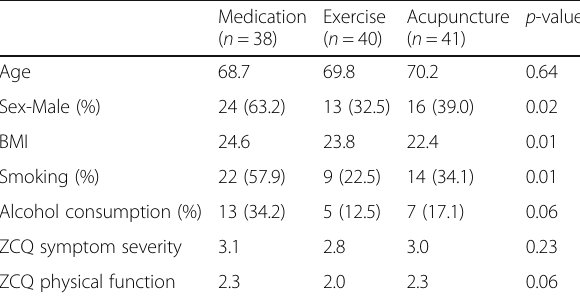
Table 1 Baseline characteristics of patient according to the treatment approaches